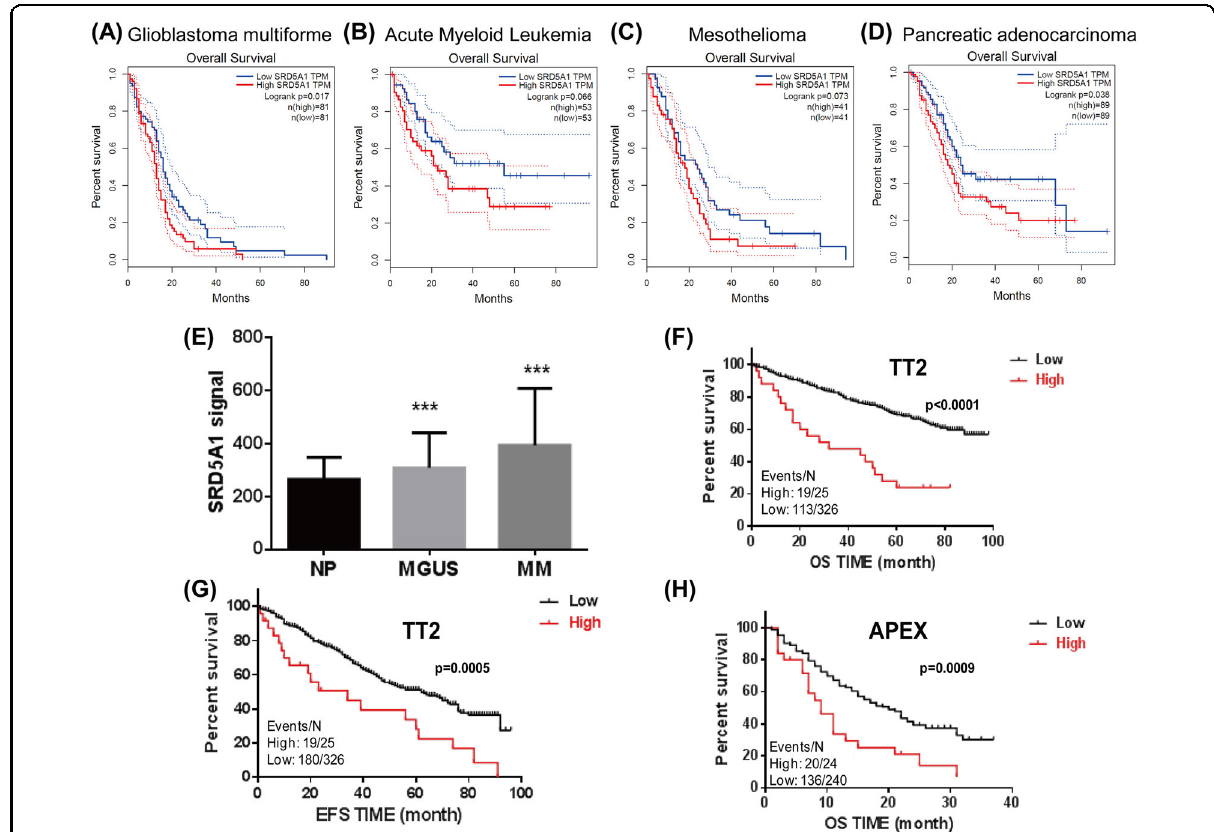
Fig. 1 SRD5A1 is a poor prognostic marker in MM. A – D Kaplan – Meier analysis of OS time, revealing that high SRD5A1 expression conferred inferior outcomes. E Histogram depicted the SRD5A1 signal in NP, MGUS, and newly diagnosed MM patients. F – H Kaplan – Meier analysis was performed based on SRD5A1 expression in different cohorts, the MM patients with high SRD5A1 expression had a signi fi cantly inferior OS and EFS time, and OS time was also analyzed in the APEX clinical trials. * P < 0.05, ** P < 0.01, *** P <